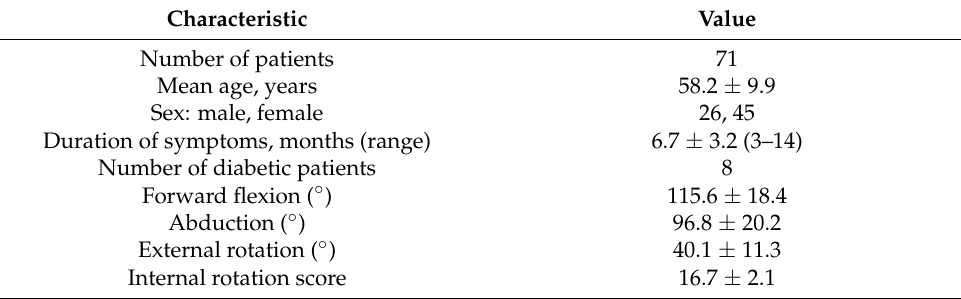
Table 1. Patient